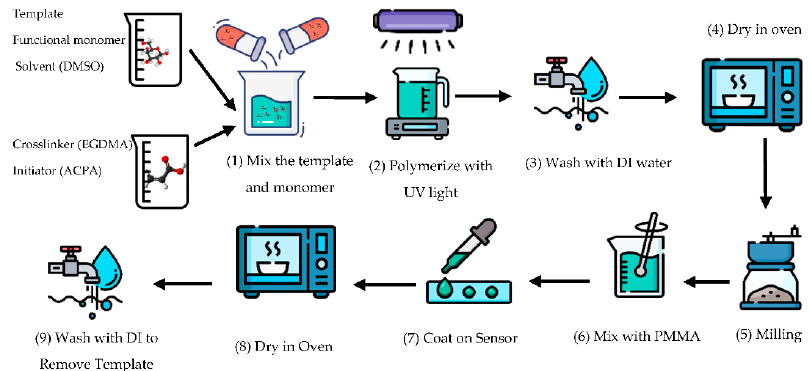
Figure 6. Illustration preparation of the sensor.